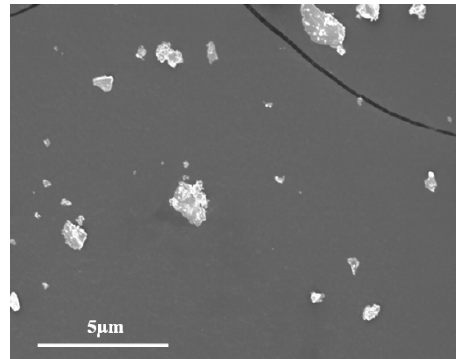
Figure 3. The SEM micrograph of as-synthesized product.